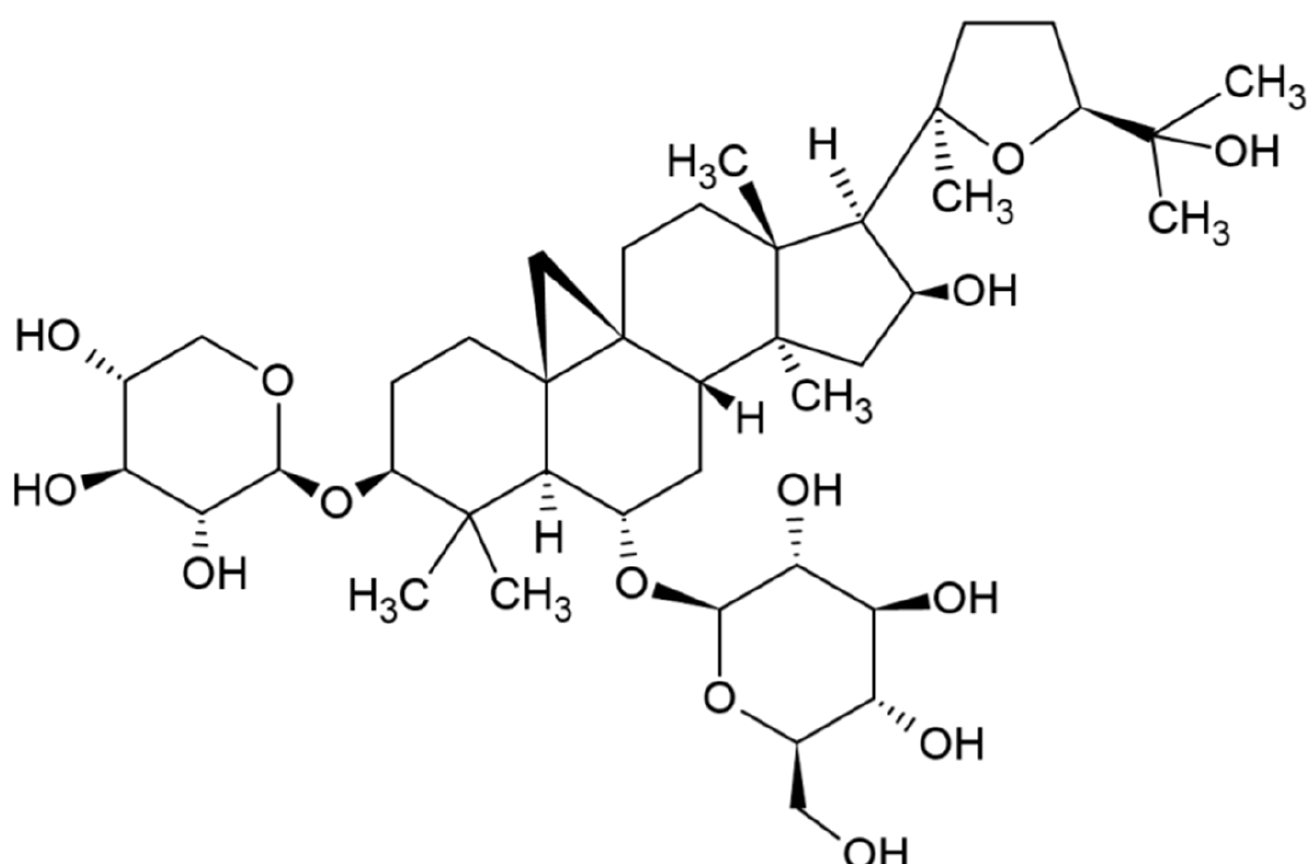
Figure 1. Chemical structure of astragaloside IV. A pentacyclic triterpenoid that is cycloastragenol having β -D-xylopyranosyl and β -D-glucopyranosyl residues attached at positions O-3 and O-6 respectively (3-O- β -D-xylopyranosyl-6-O- β -D-glucopyranosyl-cycloastragenol). C 14 H 68 O 14 .